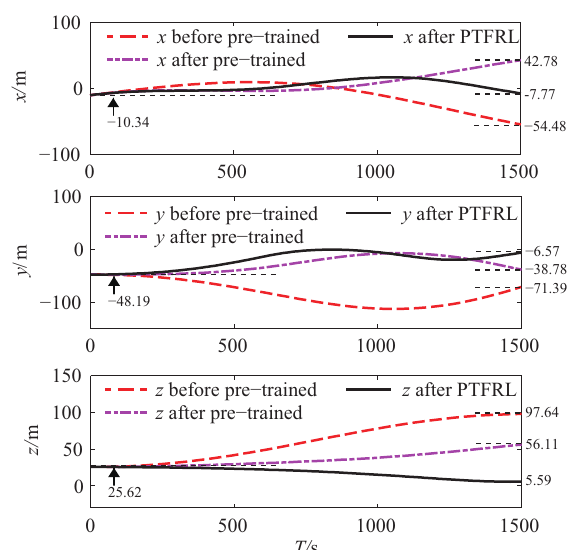
Figure 7. Variations of tracking errors in the x , y , and z channels.